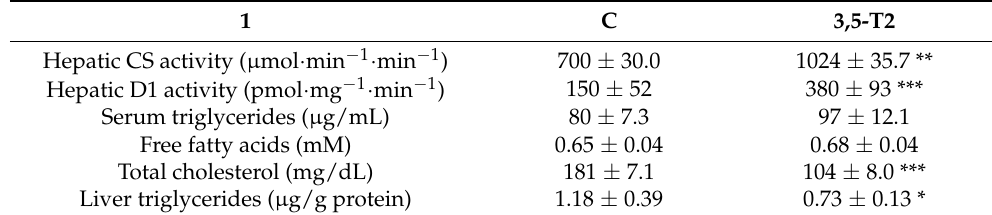
Table 1. Thyroid Hormone and Lipid Status after 3,5-T2 Treatment. Reprinted with permission from Ref. [1], © 2015, Endocrinology.